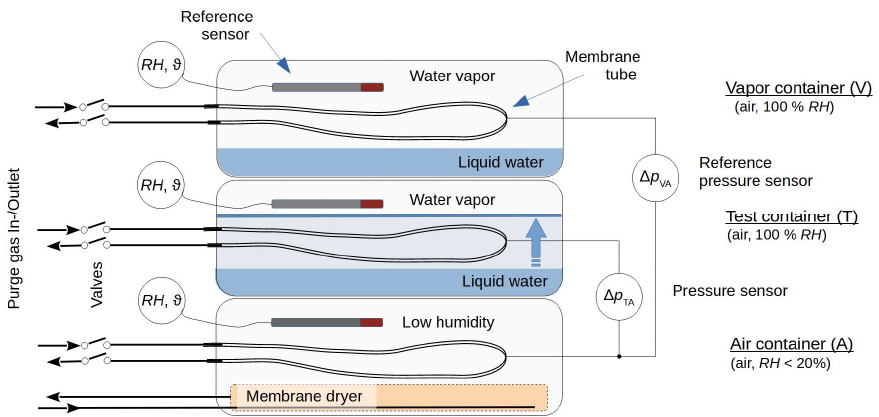
Figure 1. The setup consists of closed containers that enable the membrane tubes of the MHS to be placed in different environments: dry air (air container), vapor-saturated air (vapor container) and vapor-saturated air or liquid water (test container). The membrane tubes are connected via gas-tight tubes to valves and pressure sensors to allow the determination of the pressure differences ∆ p TA and ∆ p VA between the chambers connected in this way. Sensors for the relative humidity ( RH ) and temperature ( ϑ ) are placed in the upper parts of the